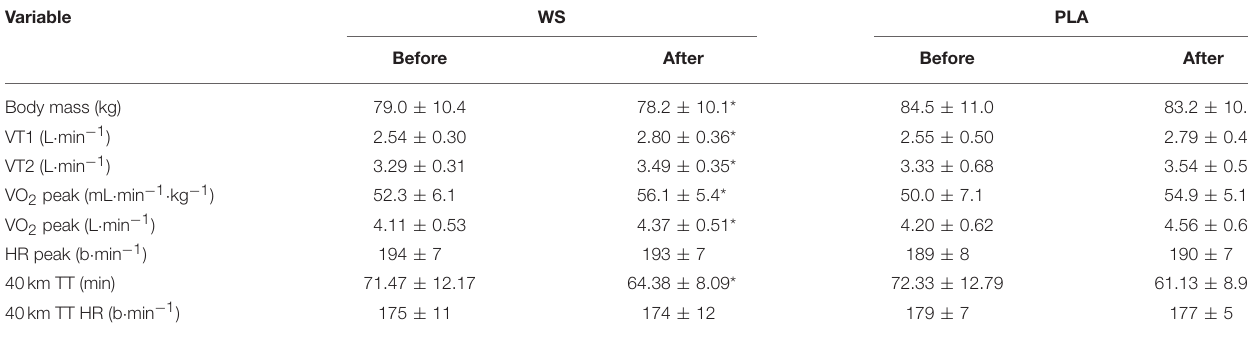
TABLE 1 | Body mass, aerobic fitness (VT1, VT2, and VO 2 peak), and performance (40km TT) for participants supplementing their diet with whey (WS) or placebo (PLA). Variable WS PLA Before After Before After